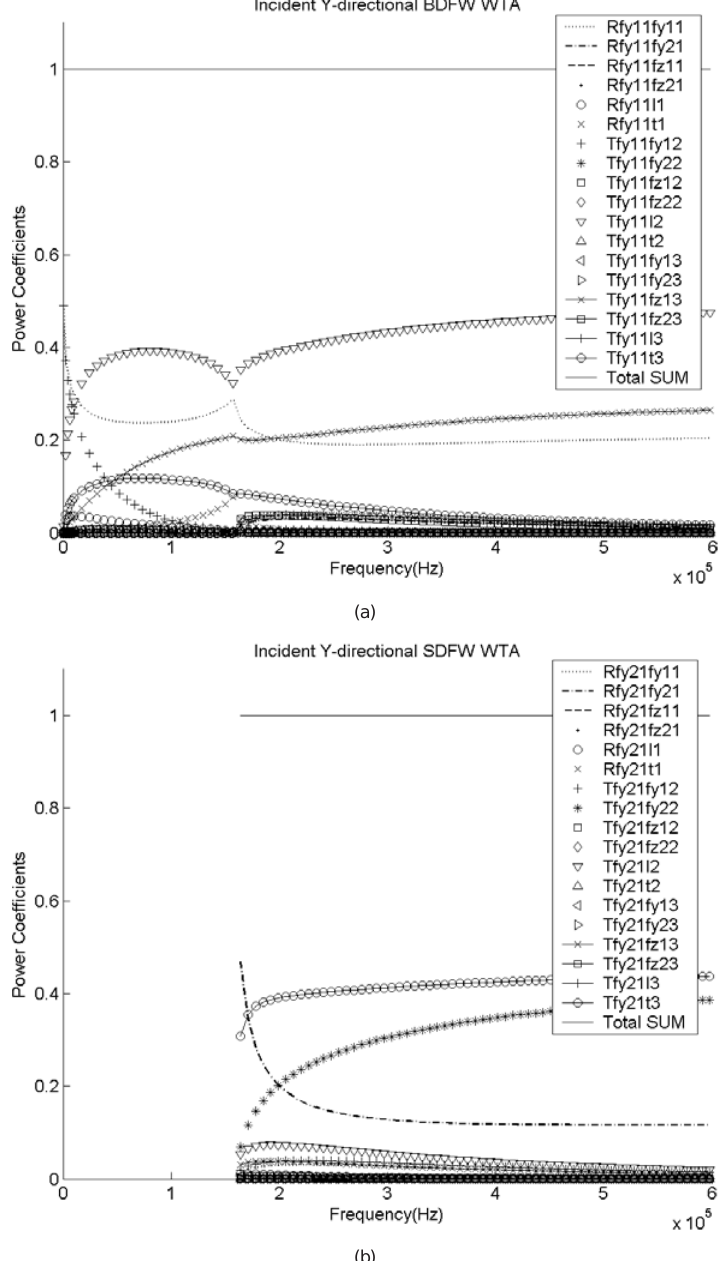
Fig. 9. The power transmission and reflection coefficients of three semi-infinite Timoshenko beams with the same material and geometrical properties joined at 90 ◦ : (a) Case of the incident y-directional flexural wave with wavenumber k 1 y , (b) Case of the incident y-directional flexural wave with wavenumber k 2 y , (c) Case of the incident z-directional flexural wave with wavenumber k 1 z , (d) Case of the incident z-directional flexural wave with wavenumber k 2 z , (e) Case of the incident longitudinal wave, (f) Case of the incident torsional